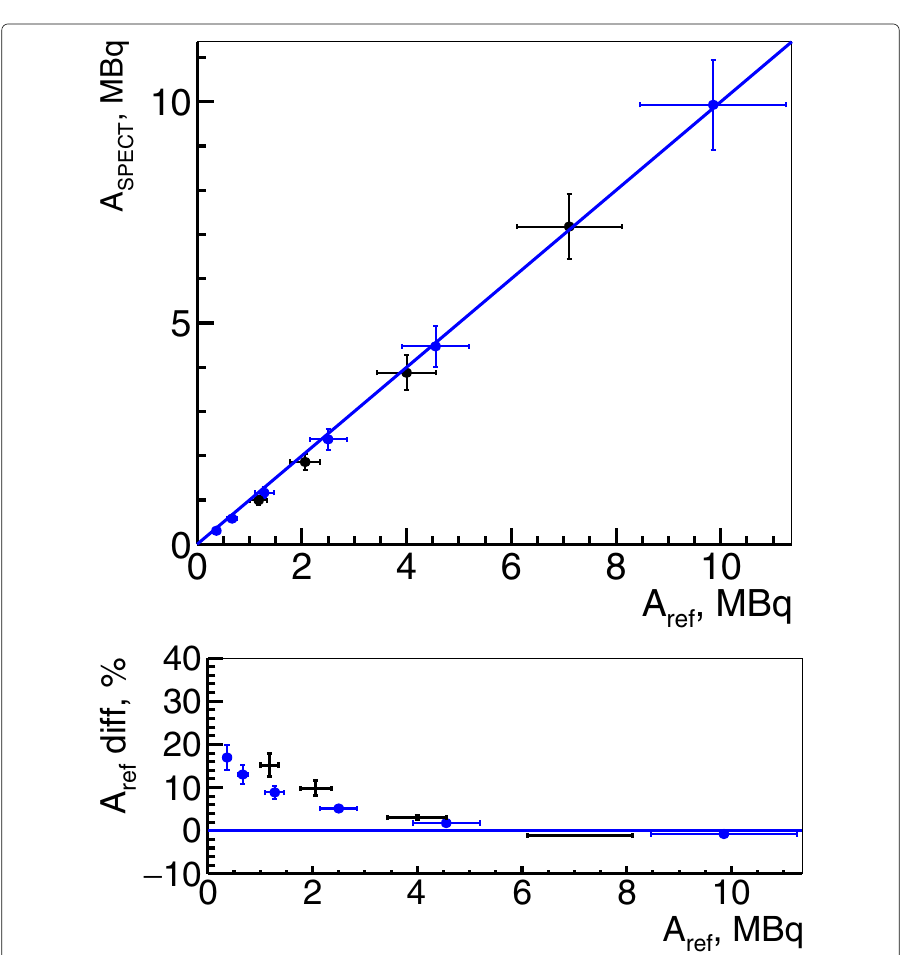
Fig. 3 Activity from SPECT images in phantom studies. Activity measured from corrected SPECT images in phantom studies for 111 In + Gd-NPs (black points) and 111 In without Gd-NPs (blue points). The error bars for measured activities are the standard